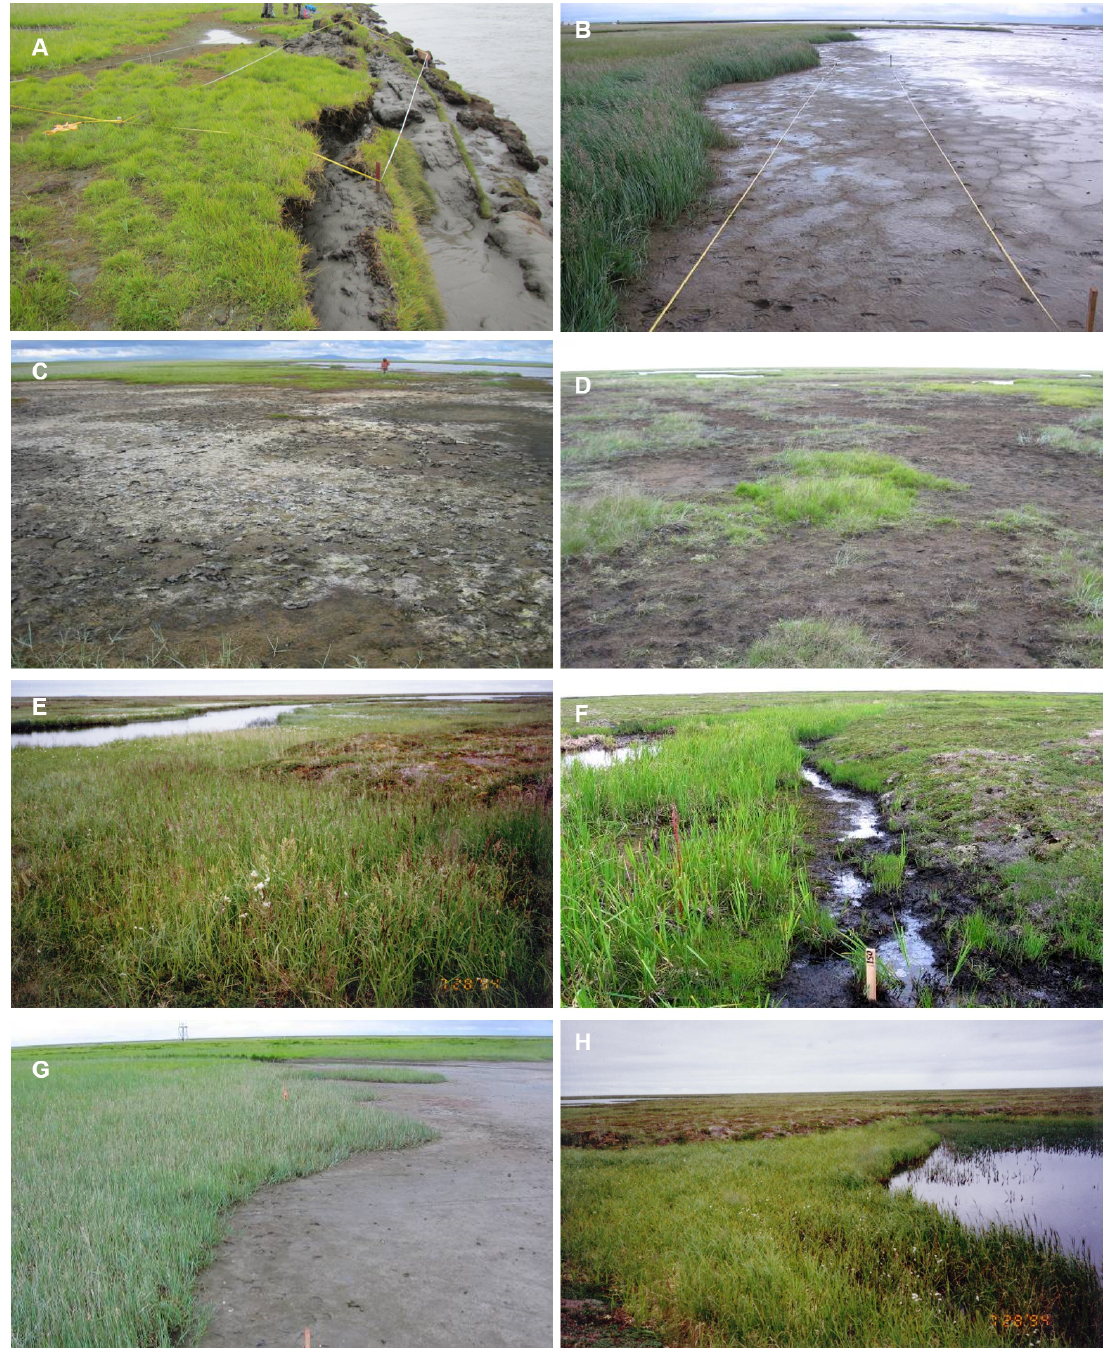
Figure 6. Field-based examples of geomorphic and ecological processes affecting landscape change, including: ( A ) channel erosion; ( B ) sedimentation from 2005 storm surge; ( C ) pond margin drying from water-level fluctuation; ( D ) salt-killed tundra from 2005 storm; ( E ) plateau created by permafrost aggradation; ( F ) permafrost degradation after salt-kill of vegetation from 2005 storm; ( G ) vegetation colonization of tidal flat; and ( H ) paludification of pond